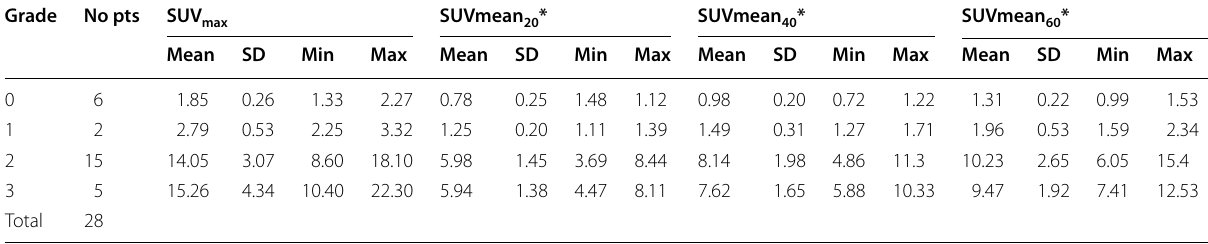
Pts, patients; SUV, standardized uptake value; SUVmean 20 , SUVmean using a segmentation threshold of 20% SUVmax; SUVmean 40 , segmentation threshold of 40%SUVmax; SUVmean 60 , segmentation threshold of 60% SUVmax *Values are mean uptake above threshold; SD, standard deviation; min, minimum; max,